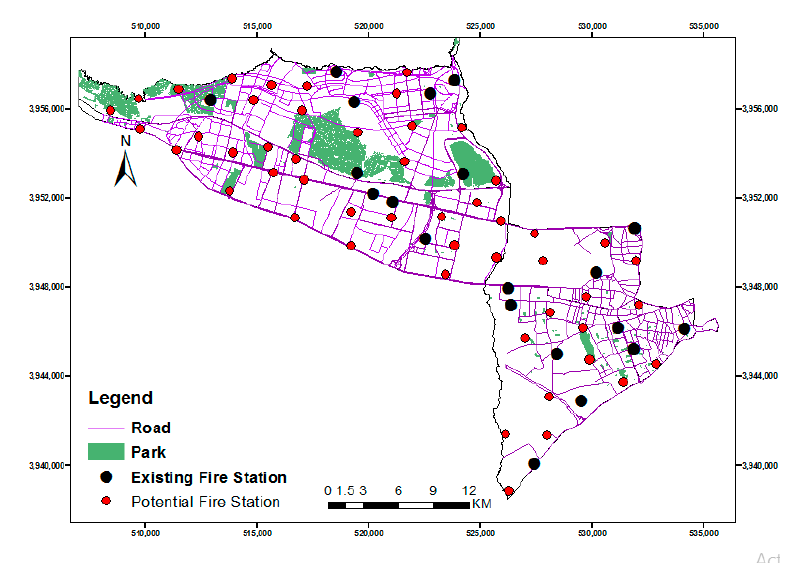
Figure 8. Location of candidate stations.